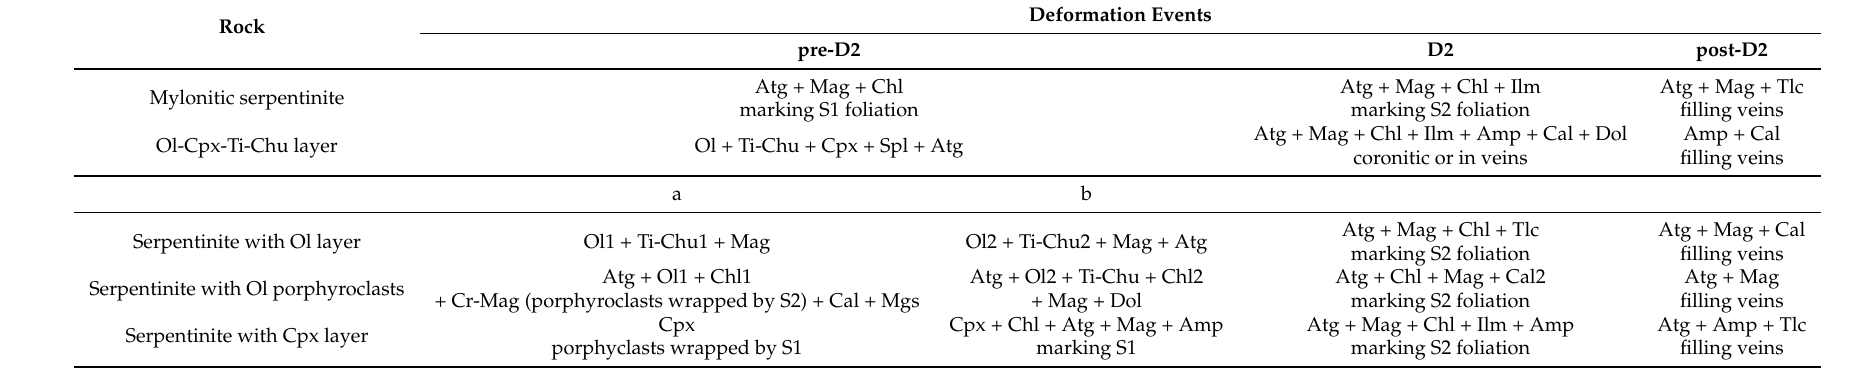
Table 2. Summary of deformation stages with and mineral associations for the studied